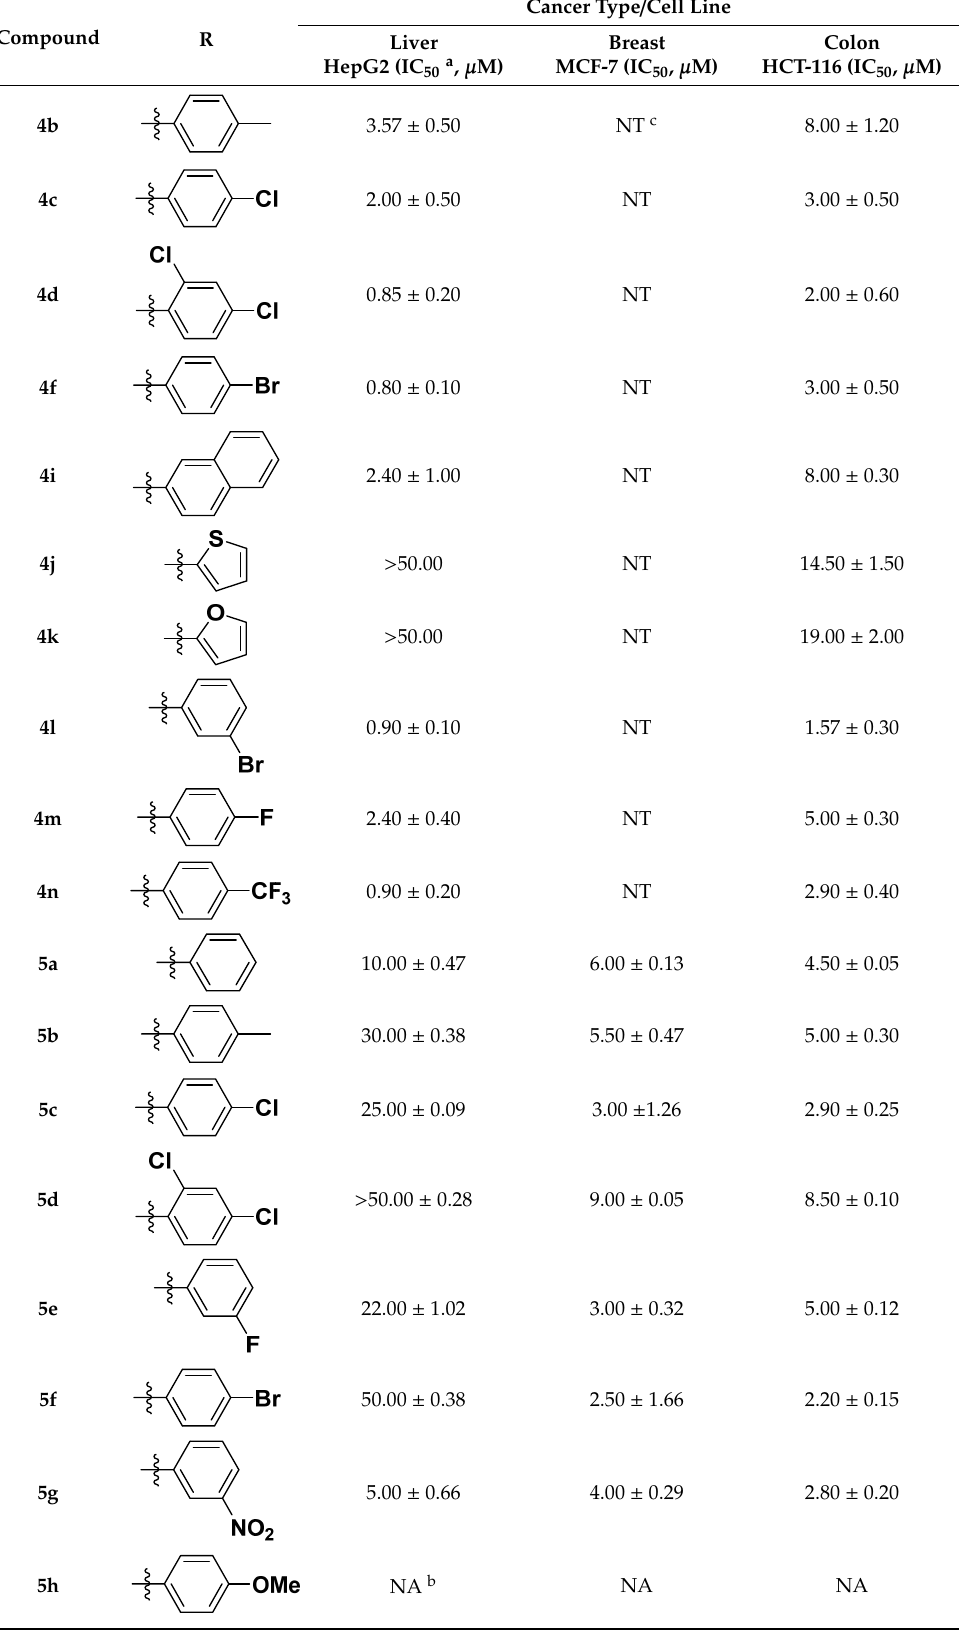
Table 1. Results of anticancer activity against HepG2, MCF-7, and HCT-116